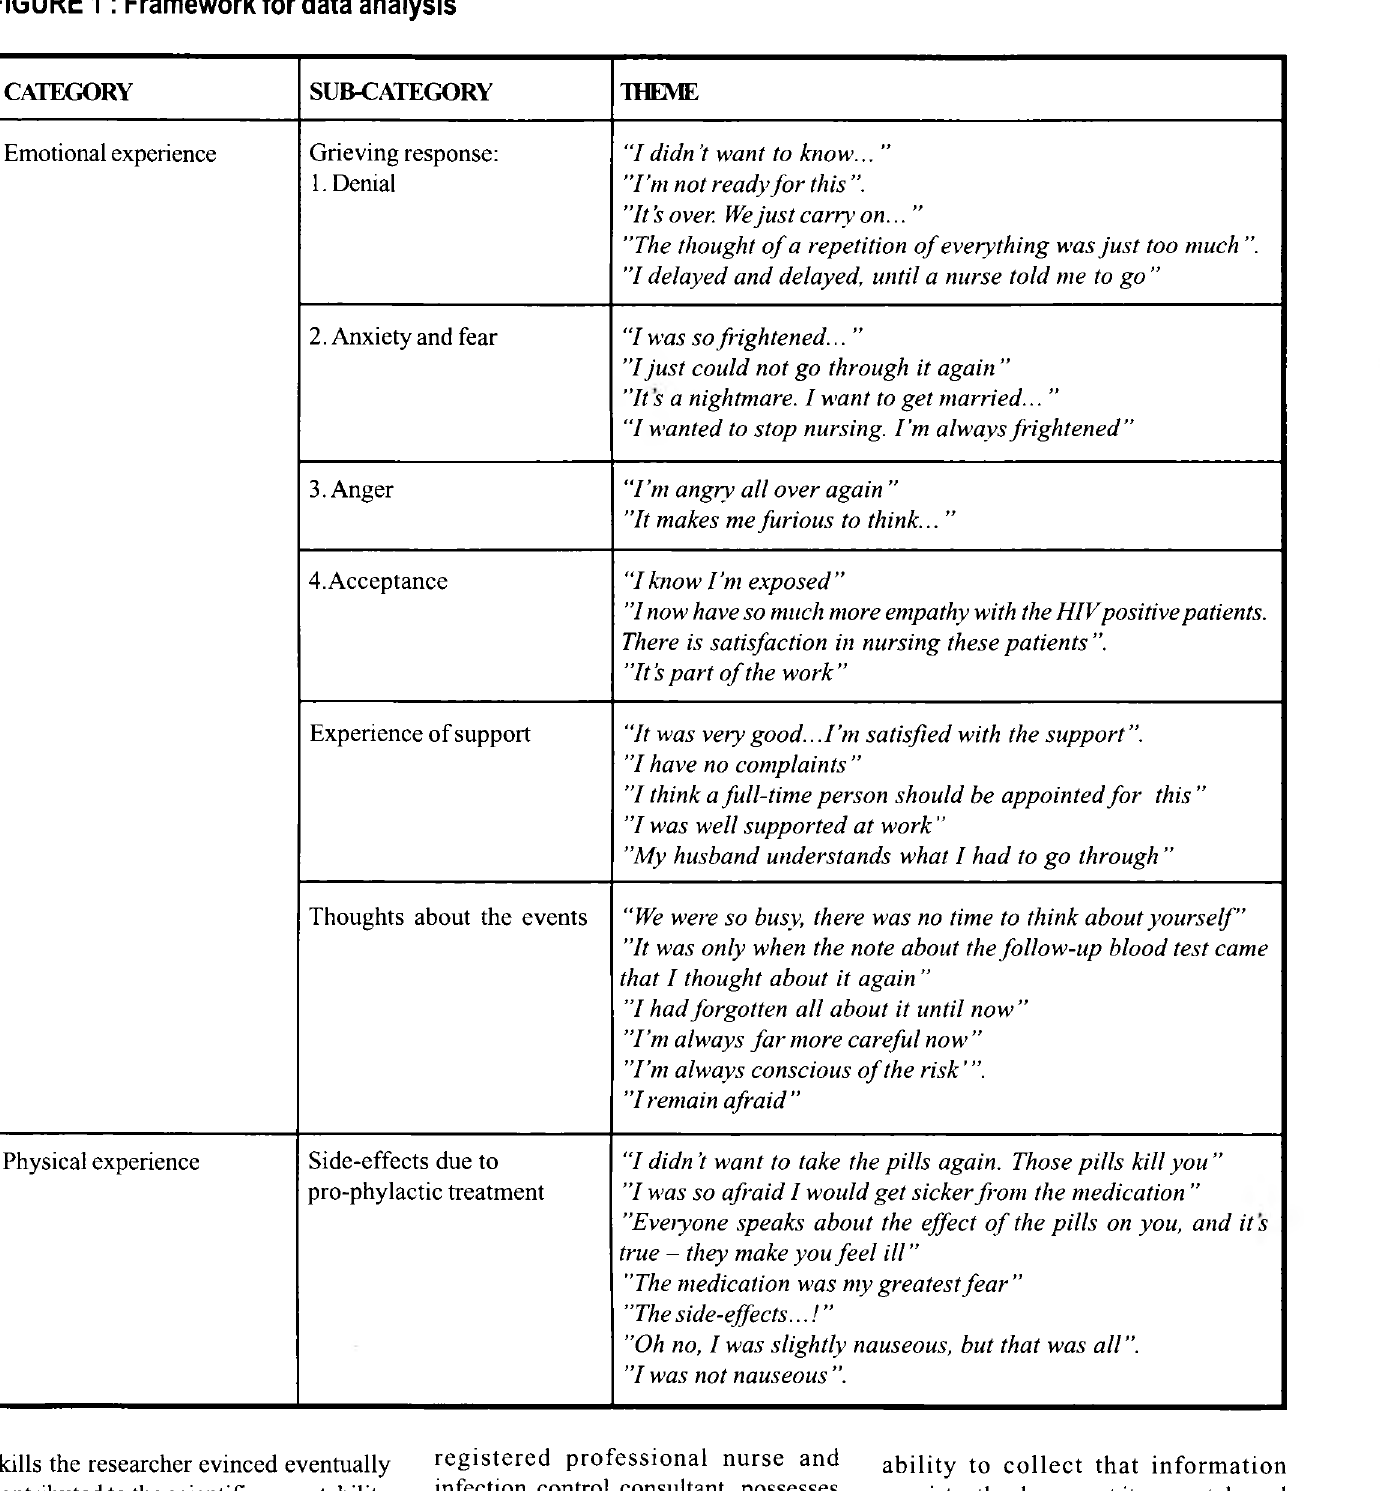
FIGURE 1: Framework for data